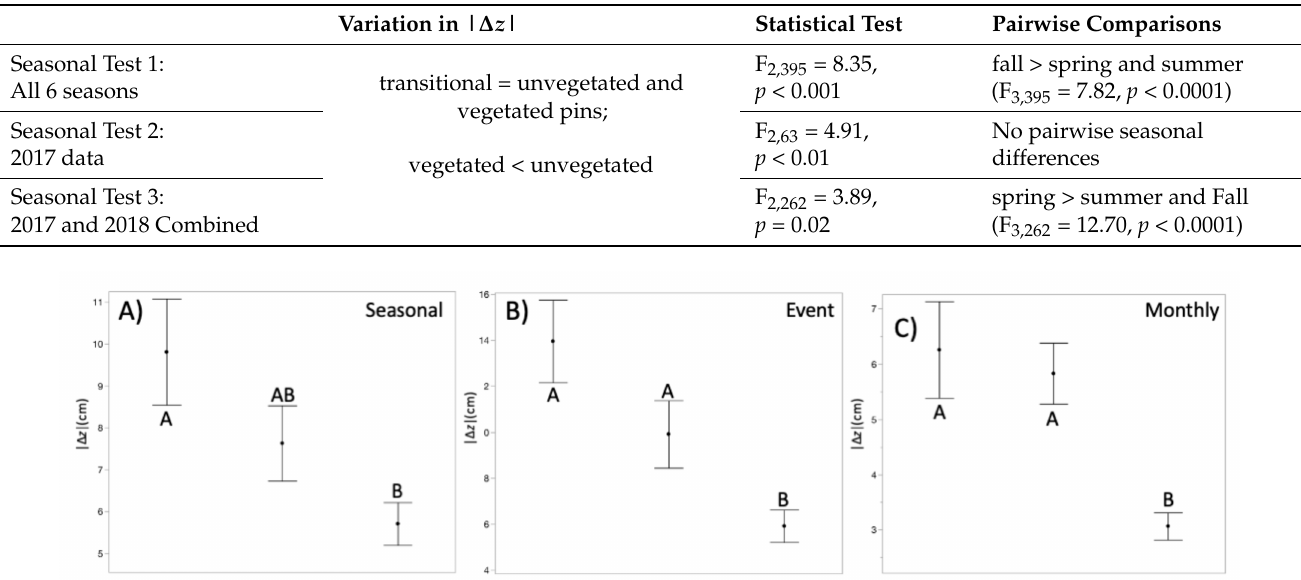
Table 3. Variation in | ∆ z | across seasons by pin type consistently supports vegetation as reducing sediment movement with pairwise differences across seasons, based on which subset of the temporal data was analyzed. Analyses were full factorial multivariate regressions. Season and pin type never had a significant interaction ( p > 0.05).